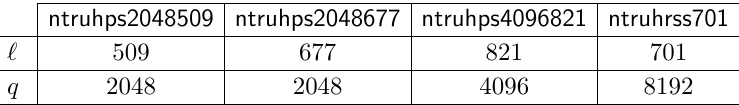
Table 2: Values of ‘ and q for the four versions of